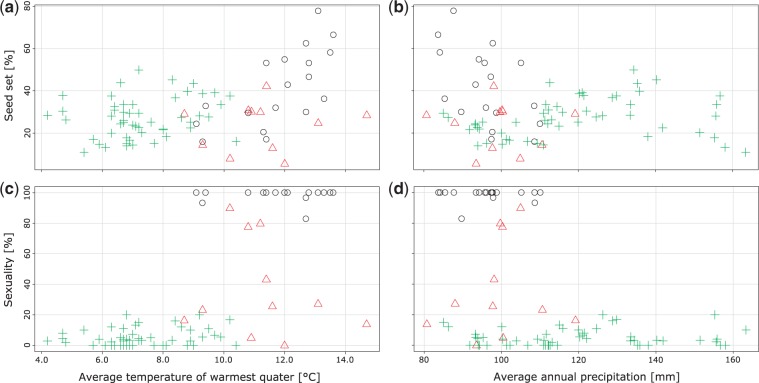
Scatterplots of ecological against developmental parameters on population level of Ranunculus kuepferi differentiated by cytotype. Black circle (o): diploid populations; green cross (): tetraploid populations; red triangle (): population consisting of individuals with different cytotypes. (a–b) Proportions of well-developed achenes averaged per flower and plant (seed set) in dependence of average temperatures of the three warmest months (a; BIO10, WorldClim) as well as in dependence of the average annual precipitation (b; BIO12, WorldClim). (c–d) Facultative sexuality in dependence of average temperatures (c) and in dependence of precipitation (d).